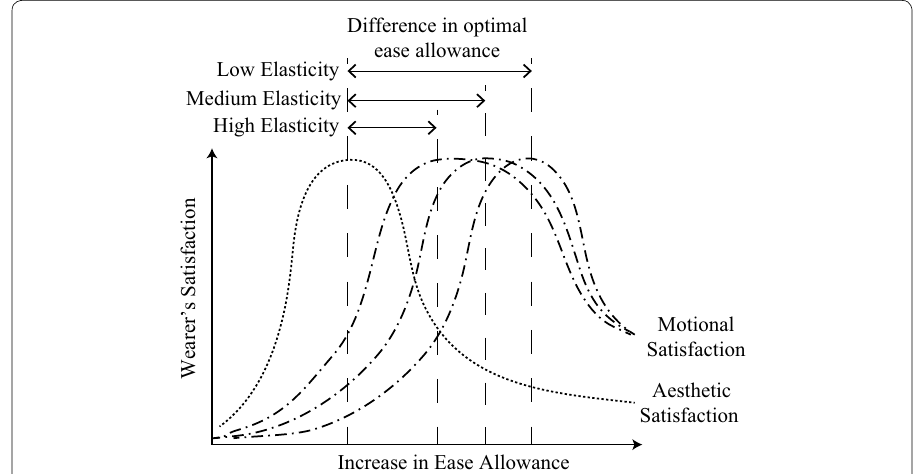
Fig. 1 Relationship between the ease allowance and the wearer’s satisfaction on wearing slim fit jackets. This schematization shows the relationship between the ease allowance and wearer’s satisfaction as well as the difference in optimal size between the motional satisfaction and the aesthetic satisfaction on wearing slim fit jackets. To maximize the aesthetic satisfaction on a slim fit, the motional satisfaction must be